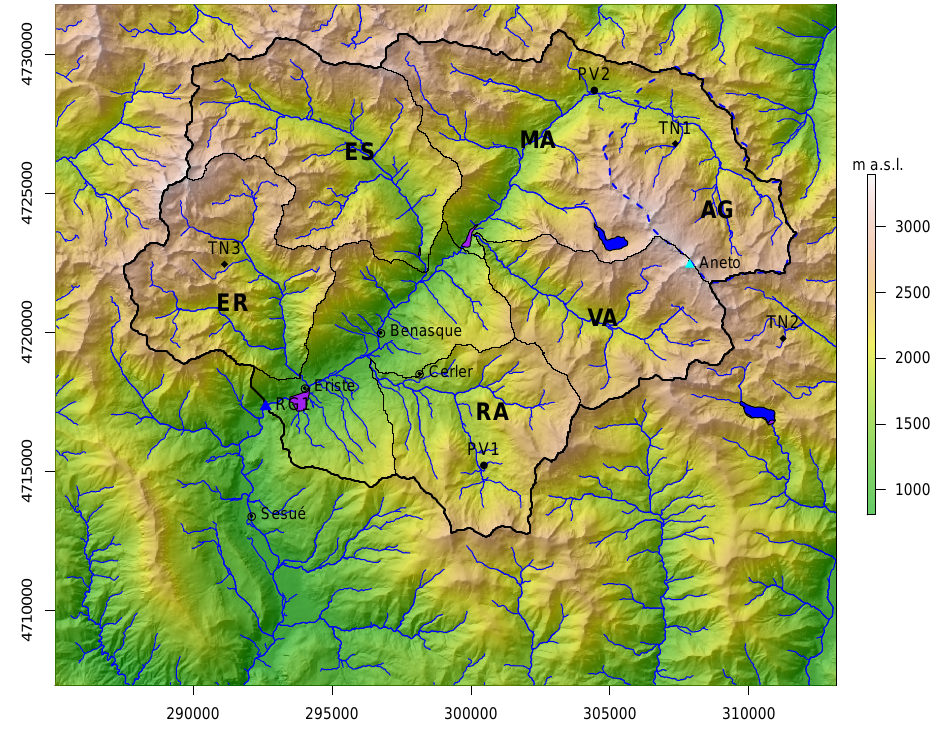
Figure 1. Map of the area of study. Coordinates are Universal Transverse Mercator UTM zone 31. The Ésera catchment and sub-catchments are shown. ER: Eriste, ES: Estós, MA: Maladeta, RA: Ramascaró and VA:Vallibierna, the Aiguallut endorheic sub-catchment is indicated by AG. Aneto, to the northeast is the highest peak in the range. Main towns are indicated by their full name and sensors listed in Table 1 by their acronyms. River network and natural lakes are drawn in blue and artificial dams in